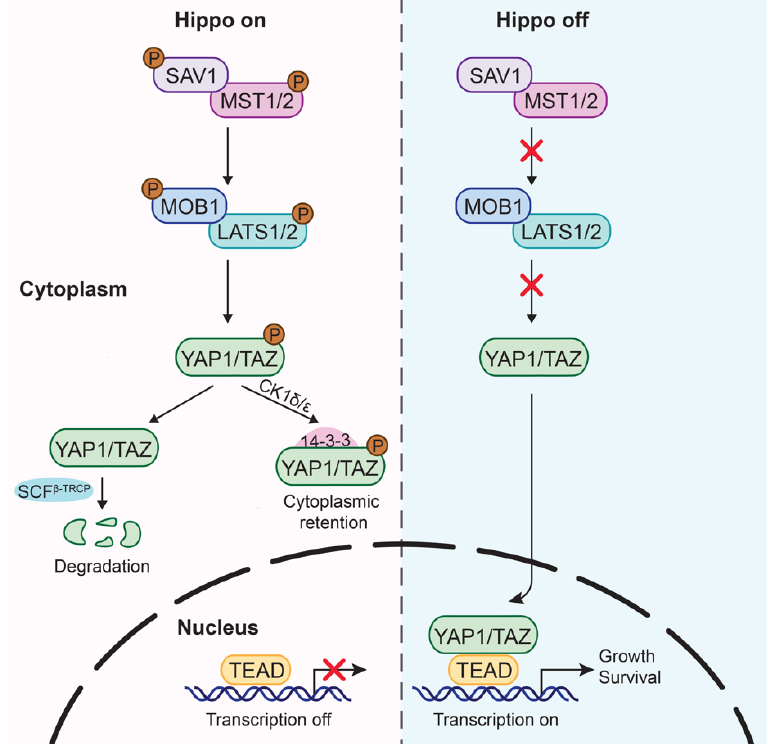
Figure 1. Core components of the Hippo pathway in human cells. When the Hippo pathway is ON, MST1/2 and SAV1 in complex phosphorylate LATS1/2 and MOB1/2. Activated LATS1/2 then phosphorylate YAP1 and TAZ, leading to YAP1/TAZ cytoplasmic retention or ubiquitin-mediated proteasomal degradation. On the other hand, when the Hippo pathway is OFF, dephosphorylated YAP1/TAZ translocate into the nucleus, where they bind with TEADs to induce the transcription of downstream target genes involved in cell growth and survival.